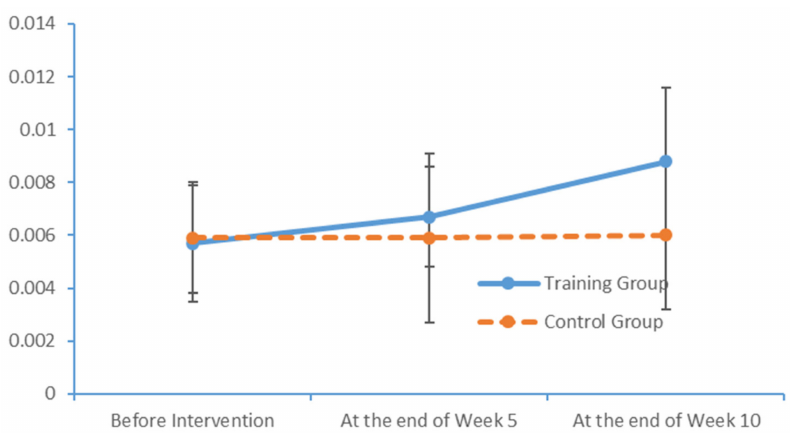
Figure 10. Changes in the power values of the alpha_hemi_right wavebands measured in the two subject groups at several time points.